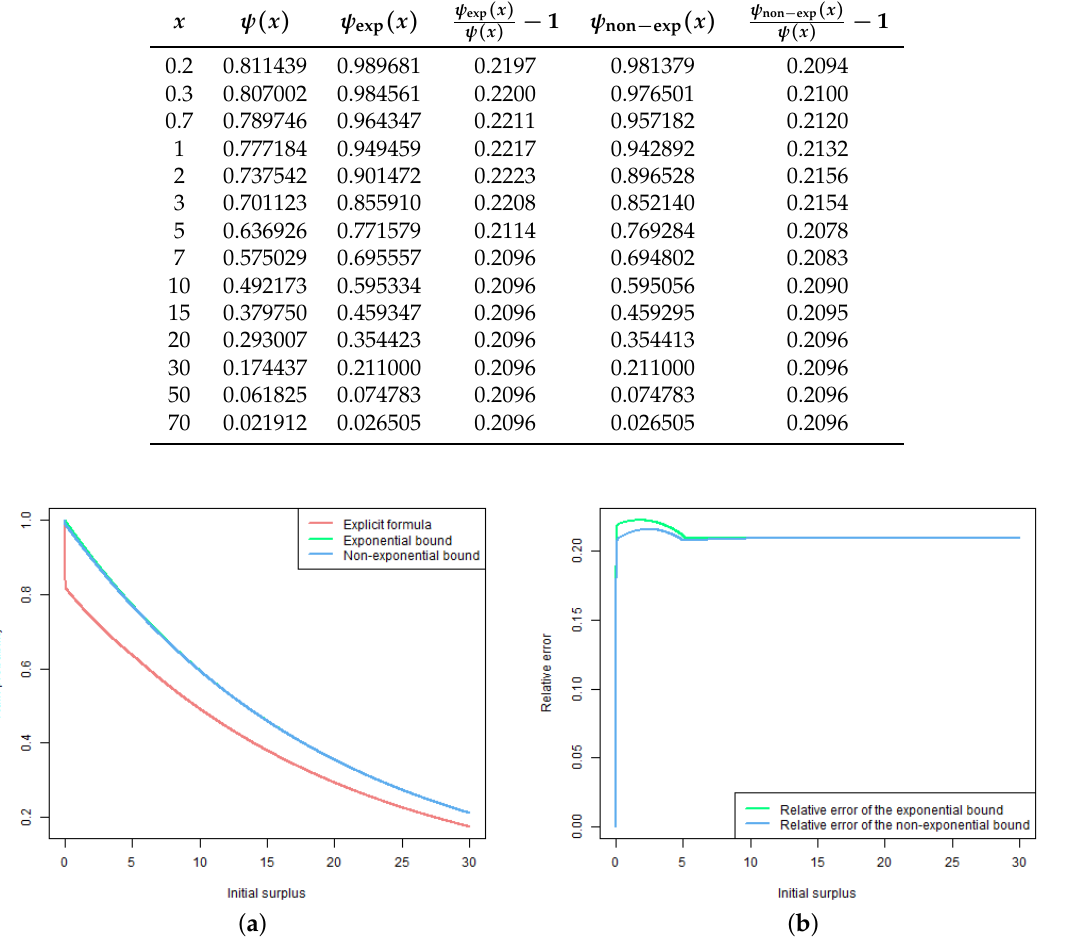
Figure 2. Comparison of the results for the model considered in Example 2: ( a ) Ruin probability given by the explicit formula as well as the exponential and non-exponential bounds for it. ( b ) Relative errors of the exponential and non-exponential